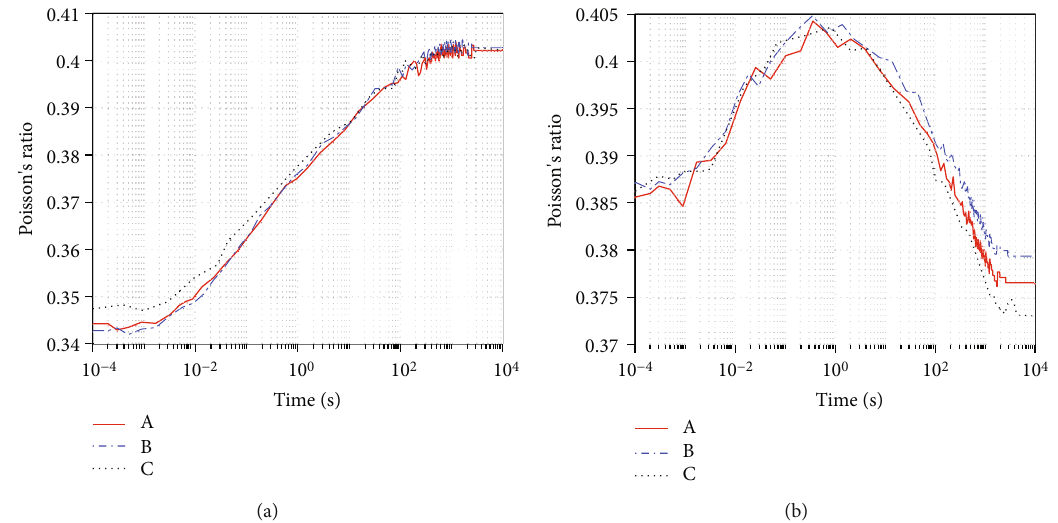
Figure 22: The curves of Poisson ’ s ratio versus time from di ff erent realizations when cohesive strength equals to (a) 0.2MPa and (b) 1.0MPa. Table 8: The percent of (standard deviation/average) for Poisson ’ s ratio at fi ve time points. Time (s) 0.0001 Standard deviation/average (Figure 22(a)) Standard deviation/average (Figure